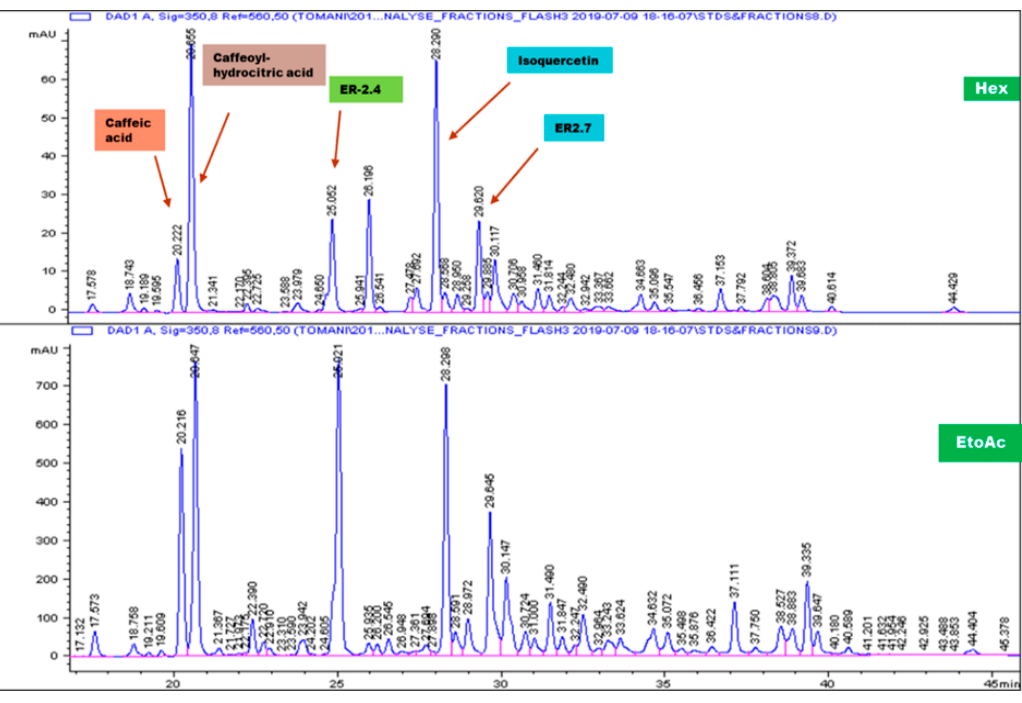
Figure 1. High performance Liquid Chromatography (HPLC) Chromatograms of the hexane (Hex) and ethylacetate (EtoAc) fractions of H. noldeae . An in-house HPLC method used to screen the major components of crude extract was used. Analytical separation was carried out on a Hypersil ODS ® RP18 column (250 × 4.6 µm; particle size 5 µm; Thermofisher Scientific, Waltham, MA, USA). All samples were dissolved in methanol HPLC-grade, filtered through a 0.45 µm pore size filter membrane and analyzed on an Agilent 1100 HPLC machine. Samples were eluted with a nonlinear gradient method with acetonitrile and 0.05% trifluoroacetic acid in ultra-pure water. The column temperature was maintained at 25 °C. Then 20 µL of each sample were injected into the HPLC-UV/DAD (Diode-Array Detection) system and the analysis, performed at a flow rate of 1.0 mL/min, was monitored at 210, 254, 288, and 350 nm.